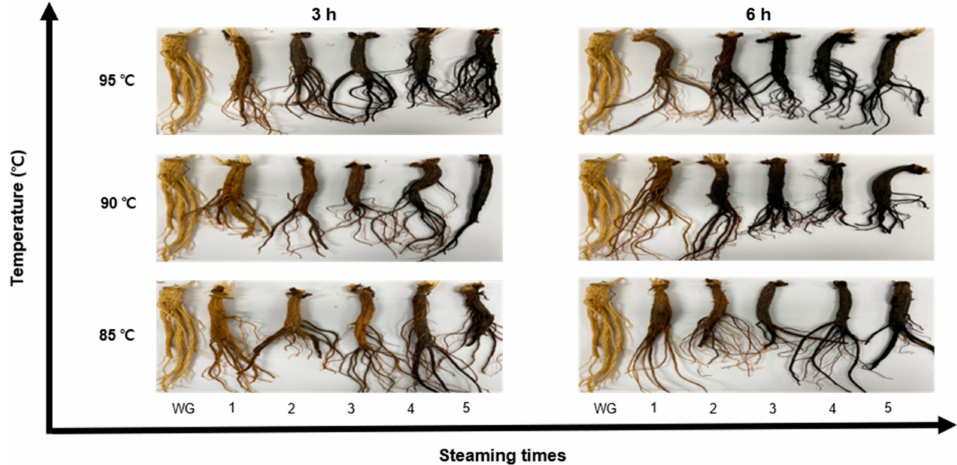
Figure 1. Change in the appearance of ginseng according to temperature and steaming time; WG: white ginseng. Observing the change in chromaticity of BG according to steaming temperature and time, the (redness) value tended to increase compared to WG based in the steaming process, as shown in Figure 2. This is due to the phenomenon that ginseng becomes red when dried by steam. However, after two steaming processes, the color changed from reddish brown to black and tended to become blacker over additional steaming processes. In the case of the b (yellowness), value it decreased continuously as the steaming process was repeated. In the case of the L (lightness) value, it decreased significantly for up to three steaming processes, after which it stabilized. The appearance of BG changes in proportion to the heat treatment time and temperature. This was similar to the results of measuring the chromaticity of manufactured BG in a study by Nam et al. [13]. The difference in color difference ( ∆ E) between SG and HG is shown in Table